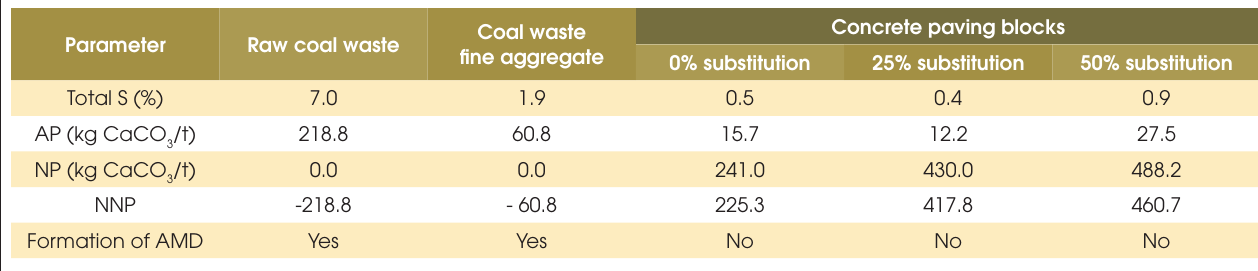
Table 4 – Acid generation prediction results of the raw waste, coal waste fine aggregate, and concrete paving blocks with 0%, 25%, and 50% of substitution of river